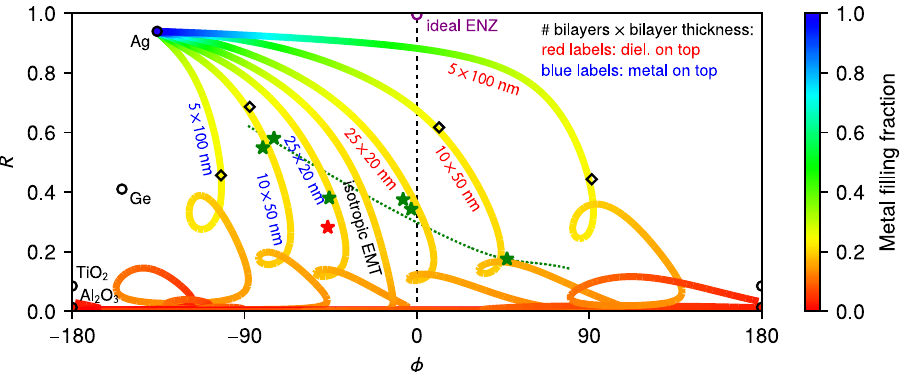
Fig. 3 Accessing the full range of re fl ectance ( R ) and re fl ected phase ( ϕ ) via layered metamaterials. R versus ϕ is illustrated for light at normal incidence with wavelength λ = 560 nm re fl ected from the surface of a thin- fi lm stack. The thick curves of varying color are exact transfer matrix numerical calculations labeled n × d , where n refers to the number of bilayers in the stack, and d the thickness of each bilayer. The total thickness nd = 500 nm is kept constant. The bilayers consist of individual Ag and Al 2 O 3 layers, with the fraction of Ag in the bilayer indicated by the metal fi lling fraction color. The red n × d labels correspond to systems where the dielectric is the upper layer in each bilayer (the one closest to the surface), while the blue labels are the ones where the metal is on top. The curve labeled EMT is the isotropic effective medium approximation to the system, which corresponds to n → ∞ , d → 0 with nd = 500 nm. In all the above cases the superstrate is water and the substrate is glass. For comparison we show points indicating the R and ϕ values for a simple interface between a water superstrate and a pure material substrate (Ag, Au, Ge, TiO 2 , Al 2 O 3 , and an ideal ENZ). We also show experimental results (green stars, details in the Supplementary Information) involving a water superstrate and fi ve trilayers (Al 2 O 3 /Ag/Ge from top to bottom, where Ge is present as a thin wetting layer to ensure fabrication quality). The dotted green trend line corresponds to keeping the Ag and Ge layer thicknesses fi xed at 15 nm and 2.5 nm, respectively, while varying Al 2 O 3 thickness from 80 nm to 20 nm (left to right). In order to compare the transfer matrix calculation with the full-wave analysis, COMSOL is used (black diamonds) to calculate R and ϕ for four different layered structure con fi gurations, with the results showing good agreement with the corresponding transfer matrix